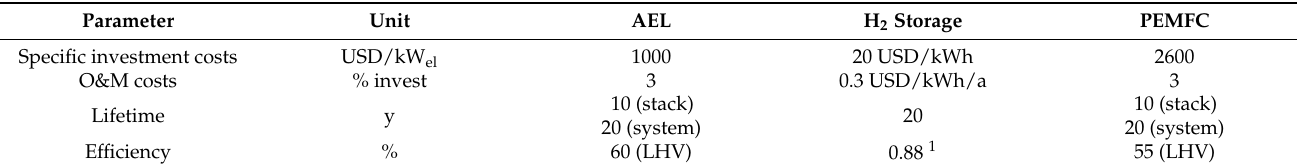
Table 4. Hydrogen system component parameter assumptions. The discussion of the parameters and literature sources consulted are provided in